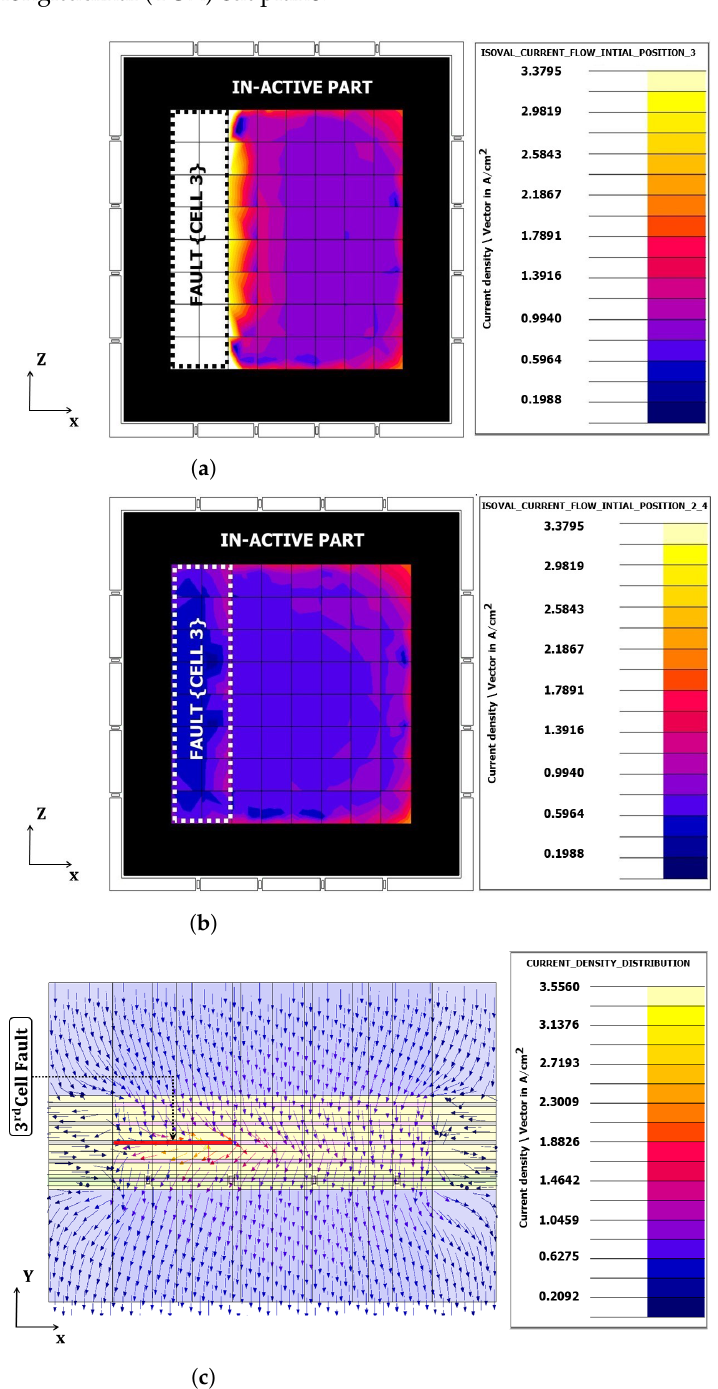
Figure 11. Current density distribution in faulty condition ( a ) cut plane (ZOX) at the level of 3rd cell, ( b ) cut plane (ZOX) at the level of 2nd and 4th cells, ( c ) cut plane